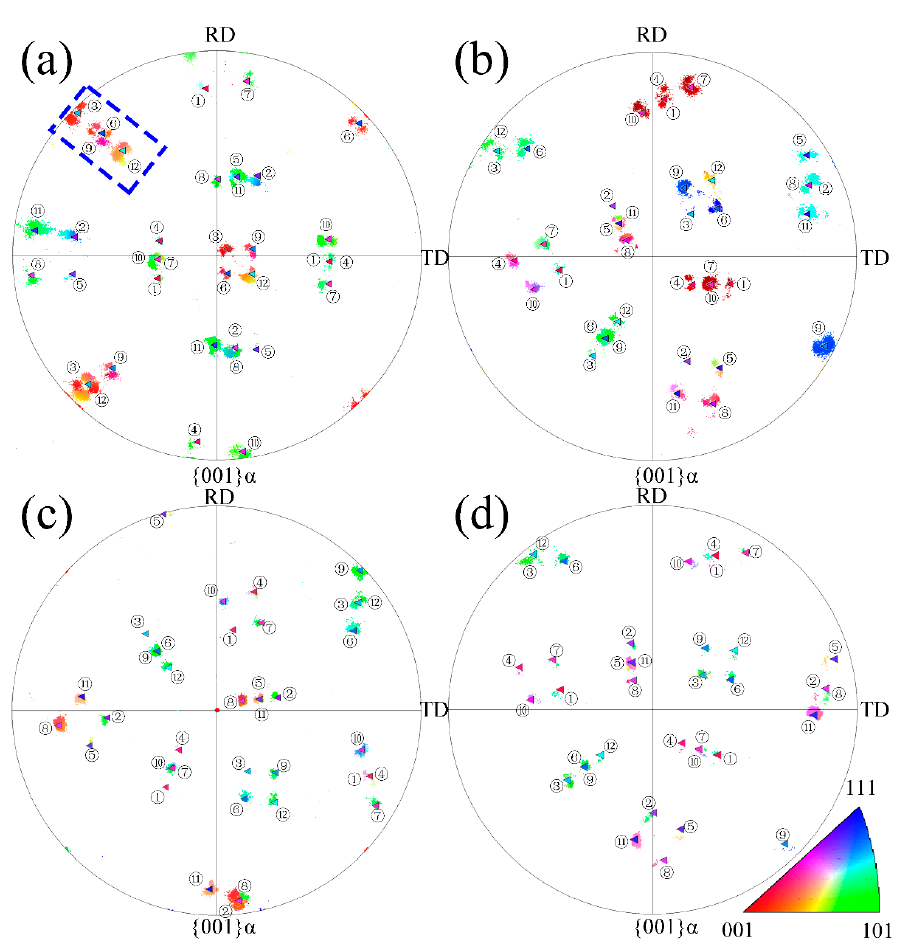
Figure 7. The determined {001} inverse pole figure of the bainitic ferrite and the comparison with the calculated variants of N ‐ W relationship of the selected areas of microstructures transformed at